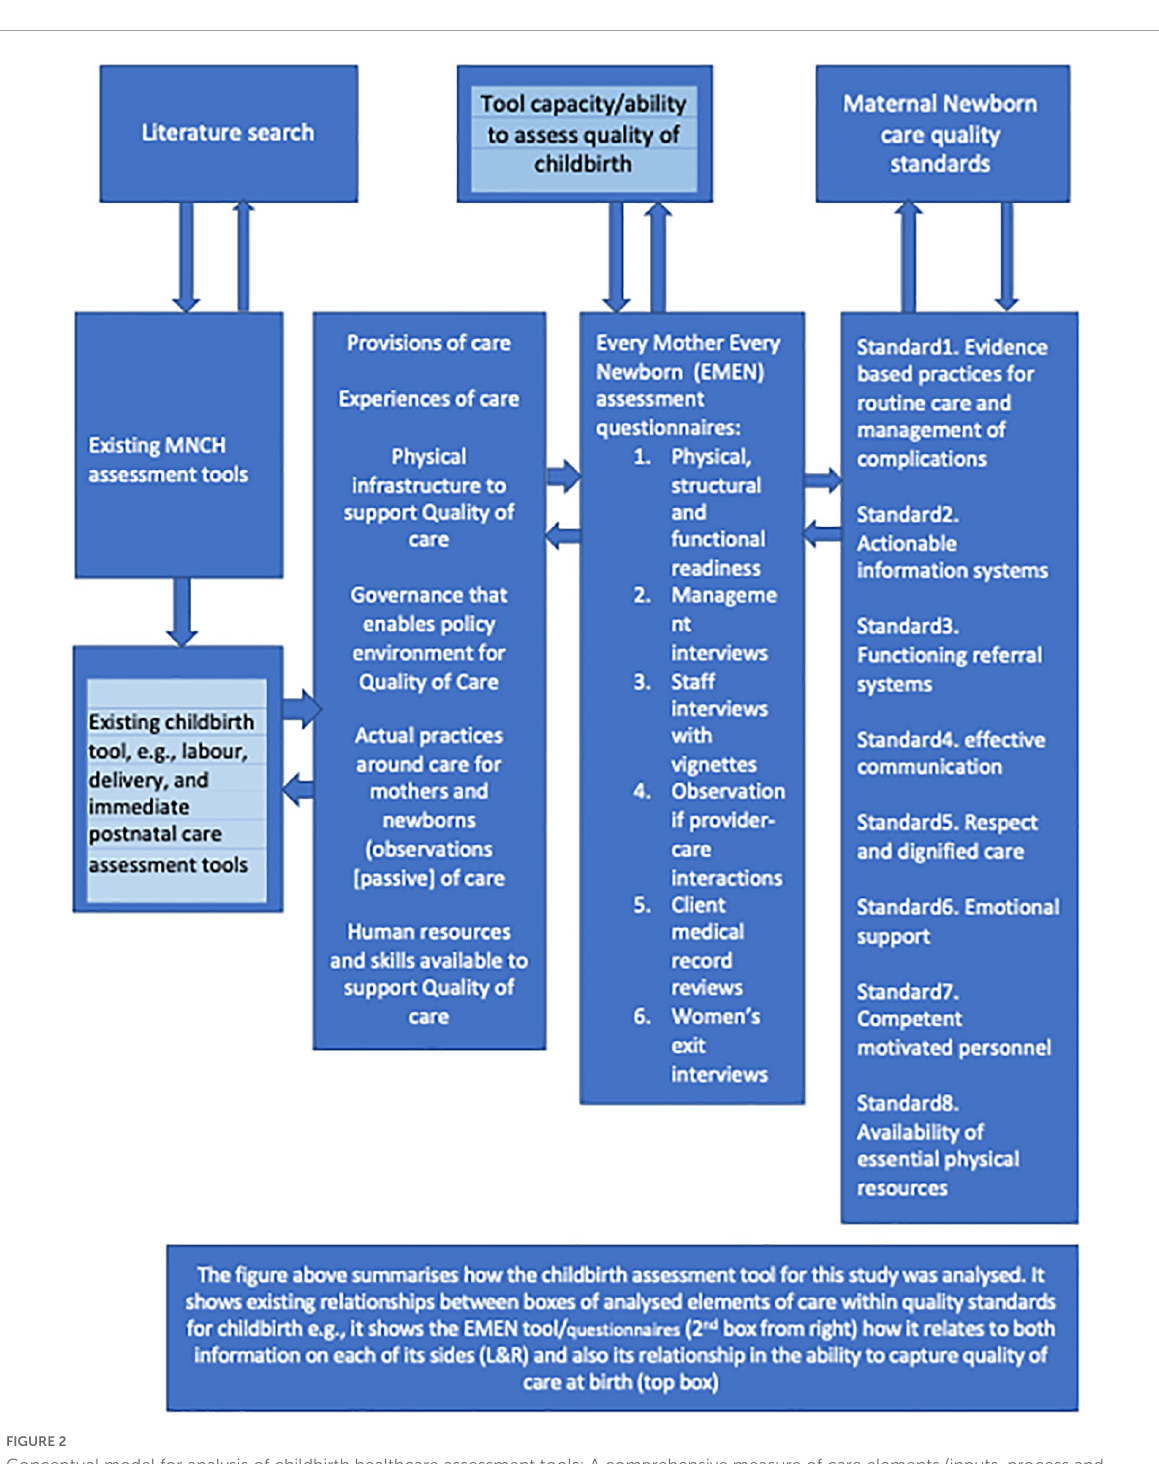
Frontiers in Pediatrics